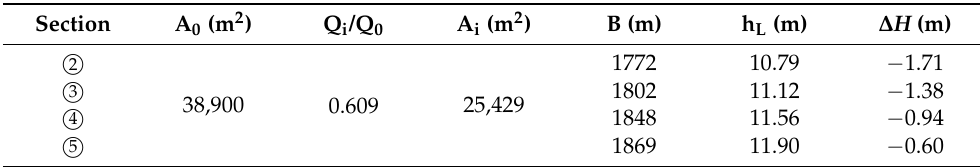
Figure 12. Positions of the sections of Shiyezhou Waterway before the project. Table 5. Equilibrium water depth of Shiyezhou